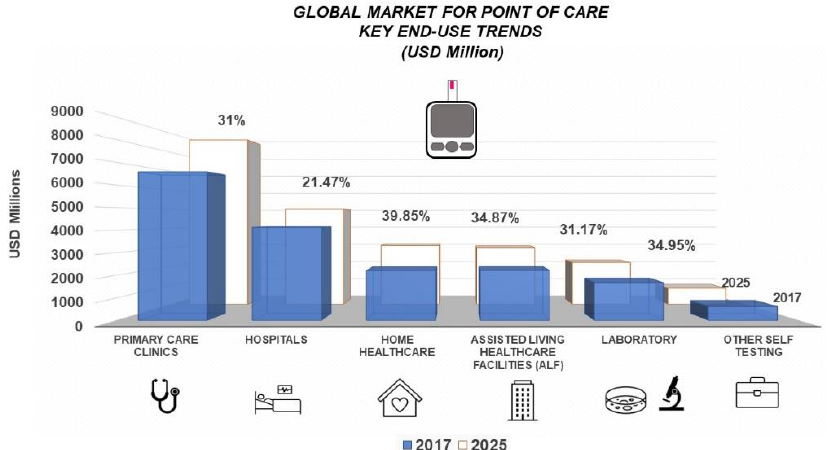
Figure 2. A schematic forecast of the Global market for PoC 2017–2025. This implies that PoC Technology can be performed in the following environments: Primary Care Clinics, Hospitals, Home Healthcare, Assisted Living Healthcare Facilities, Laboratory, and other Self Testing Areas. (Data extracted by Grand View Research´s report — See [29]).